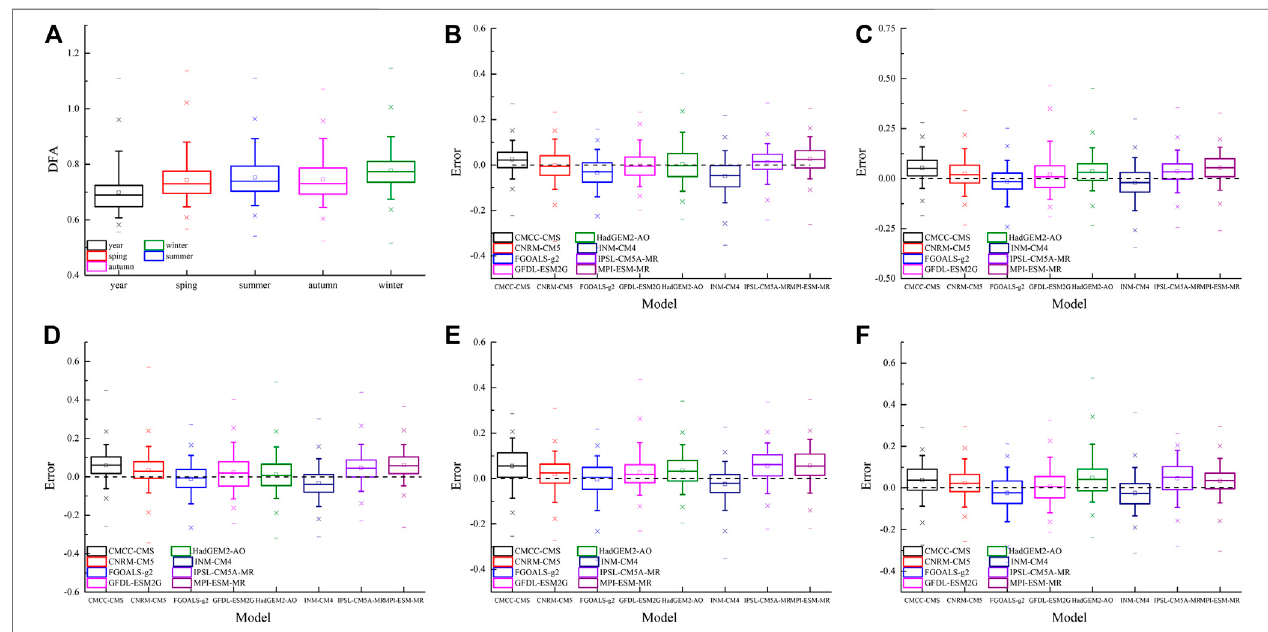
FIGURE 4 | Box charts of scaling exponents of NCEP SAT on global continents (A) and the simulation ’ s errors of LRC of model-simulated SAT for (B) year, (C) spring, (D) summer, (E) autumn, (F) winter.